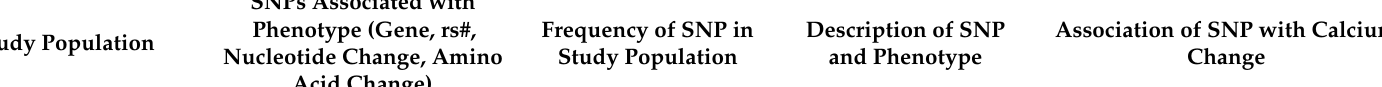
Table 4. Characteristics of studies assessing different gene